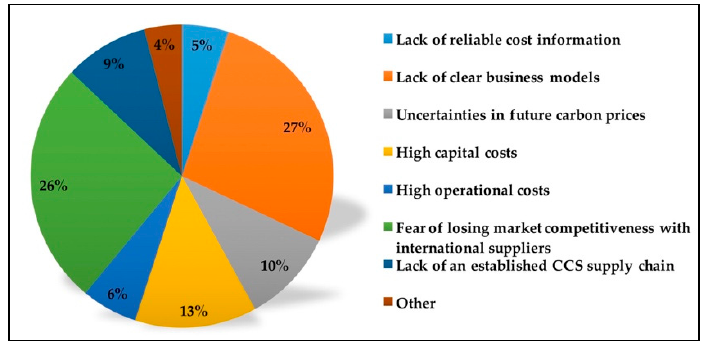
Figure 8. Perceived economic challenges of integrating CCUS within the steel industry (Q7).